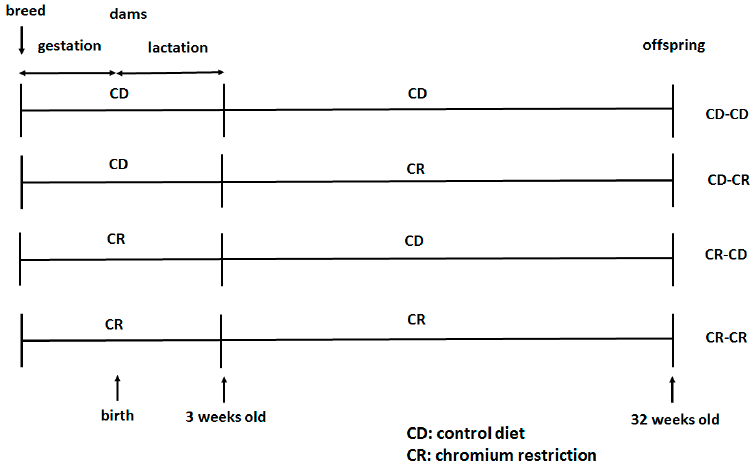
Figure 5. Schematic representation of the feeding protocol. CD, control diet; CR: chromium restriction.